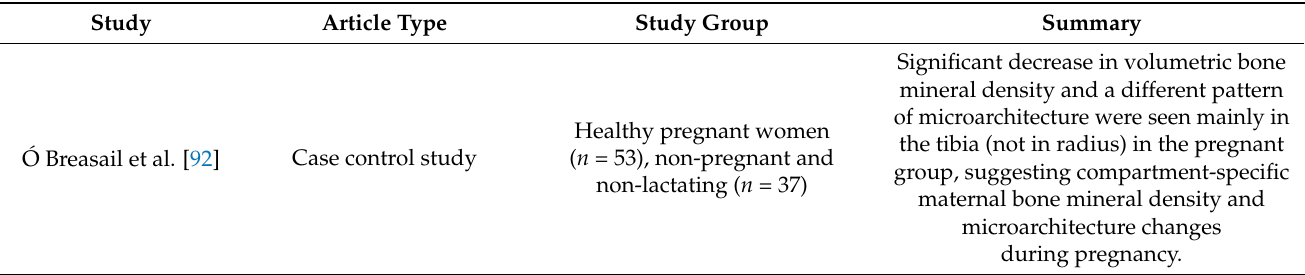
Table 4. Vitamin D deficiency and bone density in fertile women and pregnancy-related transient osteoporosis of the